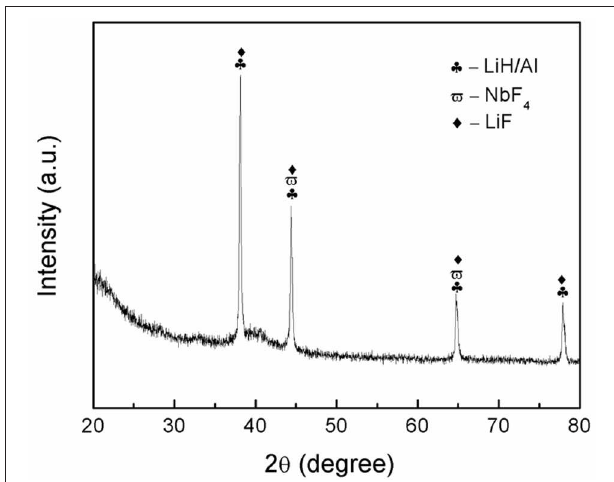
FIGURE 9 | XRD pattern of dehydrogenated LiAlH 4 + 10 wt.% K 2 NbF 7 sample at 250 ◦